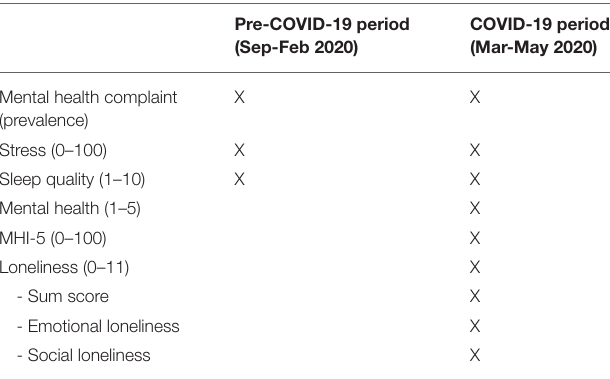
TABLE 1 | Overview of the items included in the questionnaires before and during the COVID-19